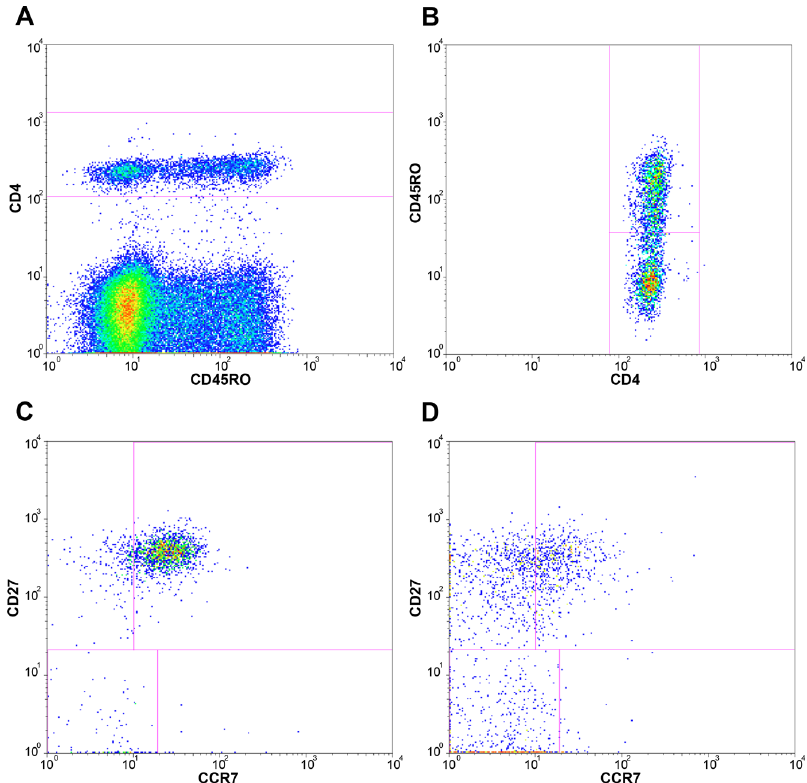
Fig 2. Gating strategy for CD4+ lymphocytes. These plots represent the gating strategy used for flowcytometry analysis of blood samples; lymphocytes were gated on a forward scatter area versus side scatter area dotplot as shown in Fig 1; A, CD4+ bright lymphocytes were gated for further determination of subpopulations; B, CD45RO- and CD45RO+ events were gated to determine na ï ve and memory subpopulations of CD4+ bright lymphocytes; Maturational T cell subpopulations were identified by analysing the (co-)expression of CCR7 and CD27 within C, na ï ve and D, memory CD8+ bright lymphocytes. controls, 8/10 had pulmonary TB and 2/10 had extrapulmonary TB. Early-onset TB-IRIS patients and their non-IRIS controls did not differ for age, sex, baseline CD4 count, baseline viral load or TB treatment duration prior to ART (Table 1). Baseline characteristics of late- onset TB-IRIS patients and non-IRIS controls were also similar, except for age. Though within matching criteria, late-onset TB-IRIS patients were a median of 5 years older than their non- IRIS controls (p = 0.028). No differences in baseline characteristics were observed between early-onset and late-onset TB-IRIS patients. Early-onset TB-IRIS occurred a median 15 (14 – 27) days after starting ART, compared to 98 (60 – 196) days for late-onset TB-IRIS patients (p < 0.001). Compared to their matched non-IRIS control time points, early-onset TB-IRIS events occurred a median of 14 days (interquartile range (IQR): 4 – 16) earlier (p = 0.002) dur- ing ART. Late-onset TB-IRIS events occurred a median of 29 (IQR: 10 – 55) days later (p = 0.022) during ART than their respective non-IRIS control time points. An additional group of 16 HIV and TB negative subjects (HIV-TB- controls) was also analysed, who did not differ significantly for age or sex from TB-IRIS patients (data not shown).